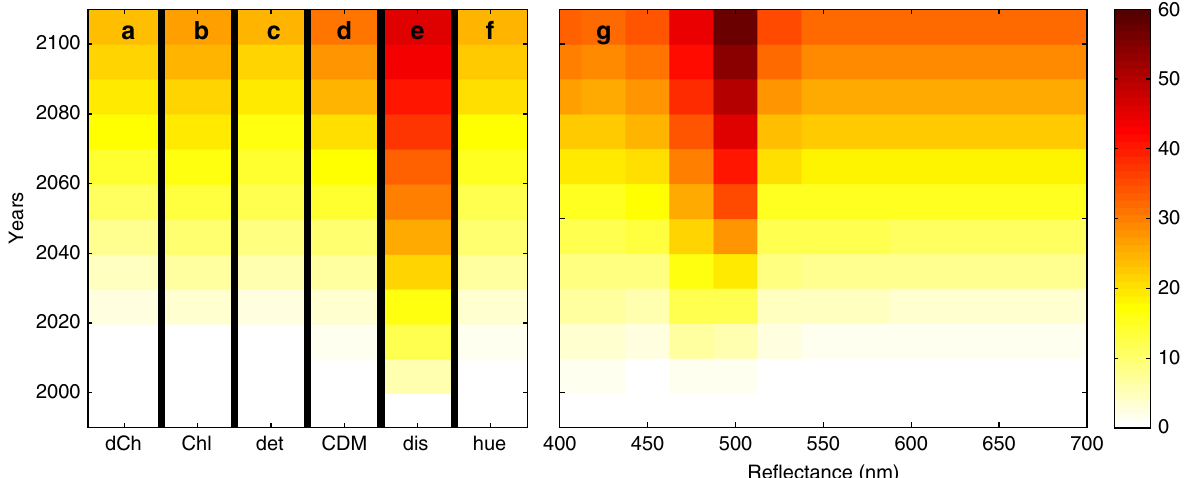
Fig. 10 Percent ocean area with signi fi cant trend. The amount of open ocean area that has statistically signi fi cant trend ( p < 0.05) since 1995 with 5-year increments. a Satellite-like derived Chl-a is the blue/green re fl ectance ratio Chl-a product calculated with an OC4-like algorithm, b actual Chl-a is the sum of the 8 dynamically changing phytoplankton which contribute to total Chl-a (as might be measured in situ); c detritus is the non-living particulate organic pool, d CDOM is the coloured dissolved organic matter, e dis refers to Bray – Curtis Dissimilarity index, and is a measure of the changes to the phytoplankton community structure; f hue refers to the hue angle, α , a metric of true colour; g the remotely sensed re fl ectance in the visible spectrum, in